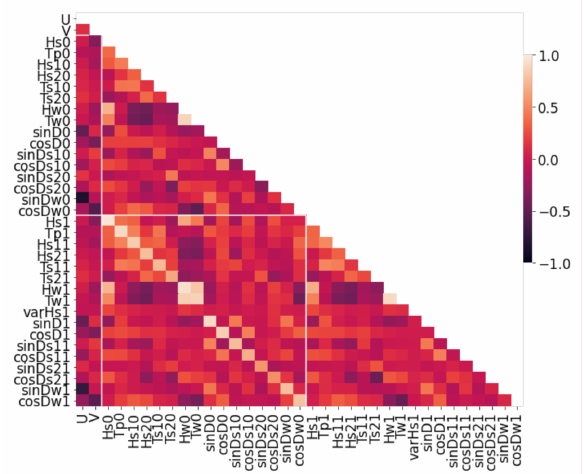
Figure 5. Correlation coefficients between all features for each